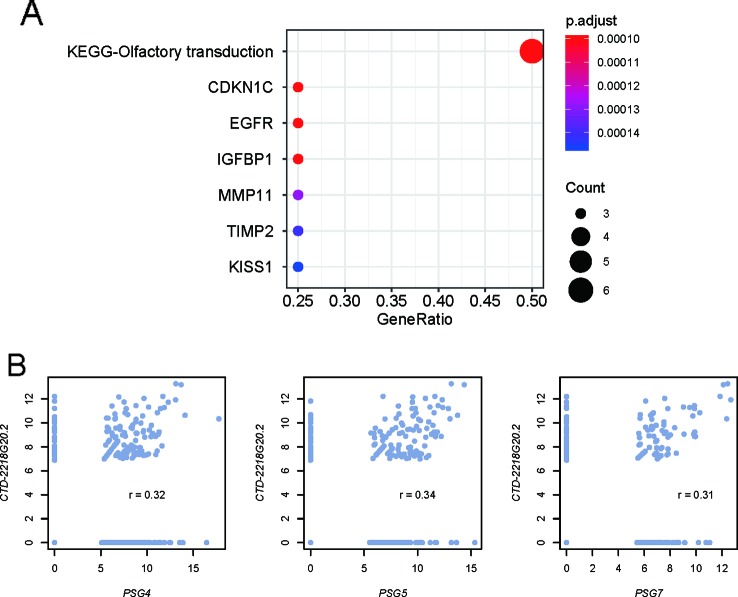
Predicted function of the prognostic lncRNA CTD-2218G20.2. (A) Gene sets enriched by the proteins predicted to interact with CTD-2218G20.2. (B) Correlation analysis between CTD-2218G20.2 and three pregnancy-specific glycoproteins. The x- and y-axes represent the expression levels (log2 (FPKM+1)) of the PSG genes and CTD-2218G20.2, respectively.